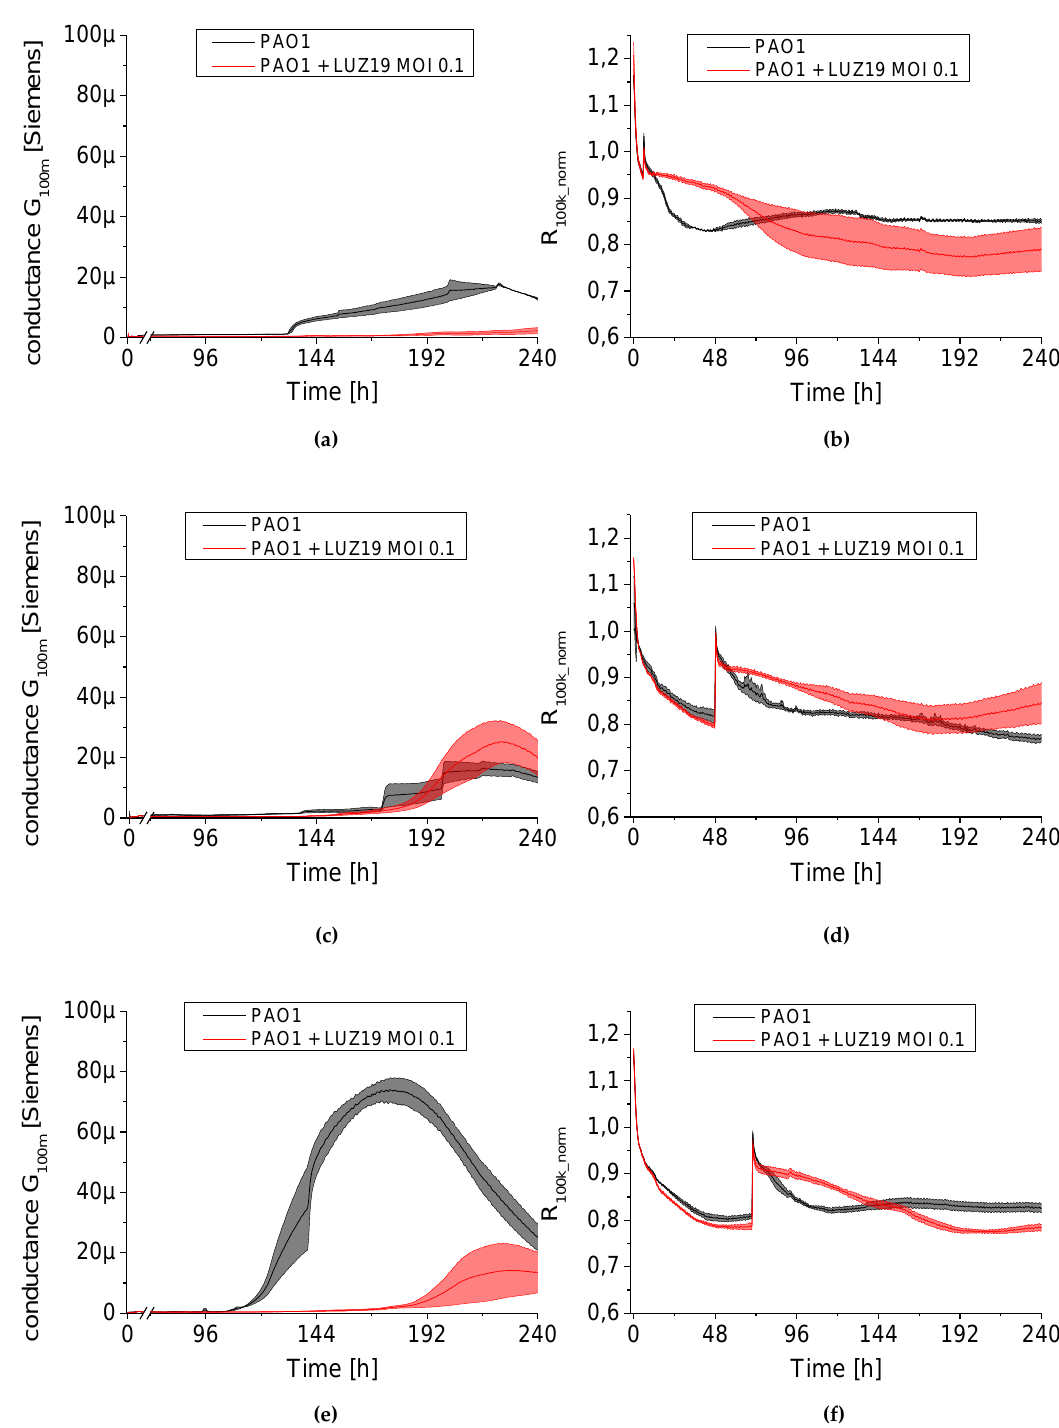
Figure 8. The changes in conductance G 100m (left panel) and resistance R 100k_norm (right panel) measured by QTF sensors during phage LUZ19 treatment of PAO1 biofilm at MOI = 0.1. Phage was applied at the 6th ( a , b ), 48th ( c , d ) and 72nd ( e , f ) hour of biofilm culture. In the right panel, for each variant, a peak appears, which is associated with the transfer of QTF sensors to new medium containing an appropriate concentration of viral particles. Data are expressed as mean of conductance G 100m ± SD and resistance R 100k_norm from three independent experiments.